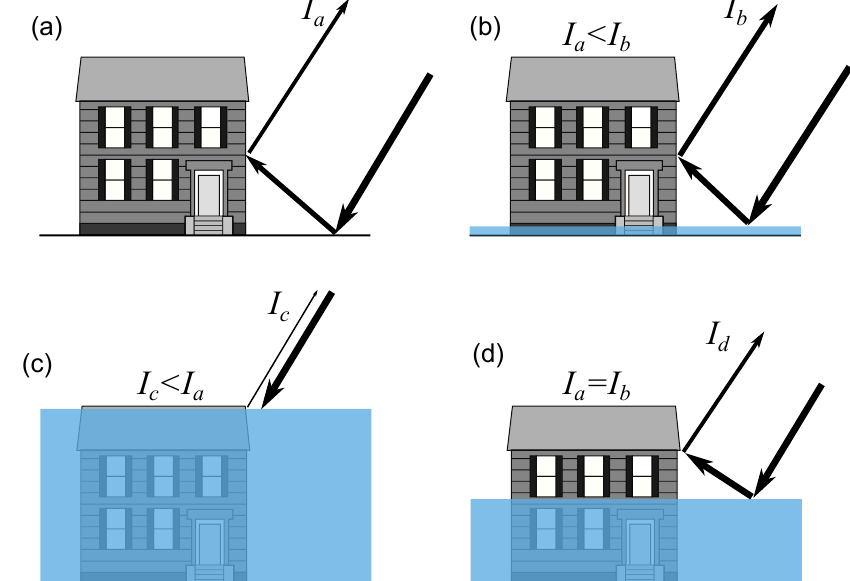
Figure 2. Simplified scheme of the of backscattering intensity mechanism and the effect of the inundation depth and building height in the backscattering magnitude. ( a ) double bounce mechanism. ( b ) specular reflection and double bounce mechanisms over a large wall area ( I a < I b ). ( c ) specular reflection and double bounce over a small wall area ( I c < I a ). ( d ) specular reflection and double bounce with backscattering intensity I d equal to the case shown in ( a ).